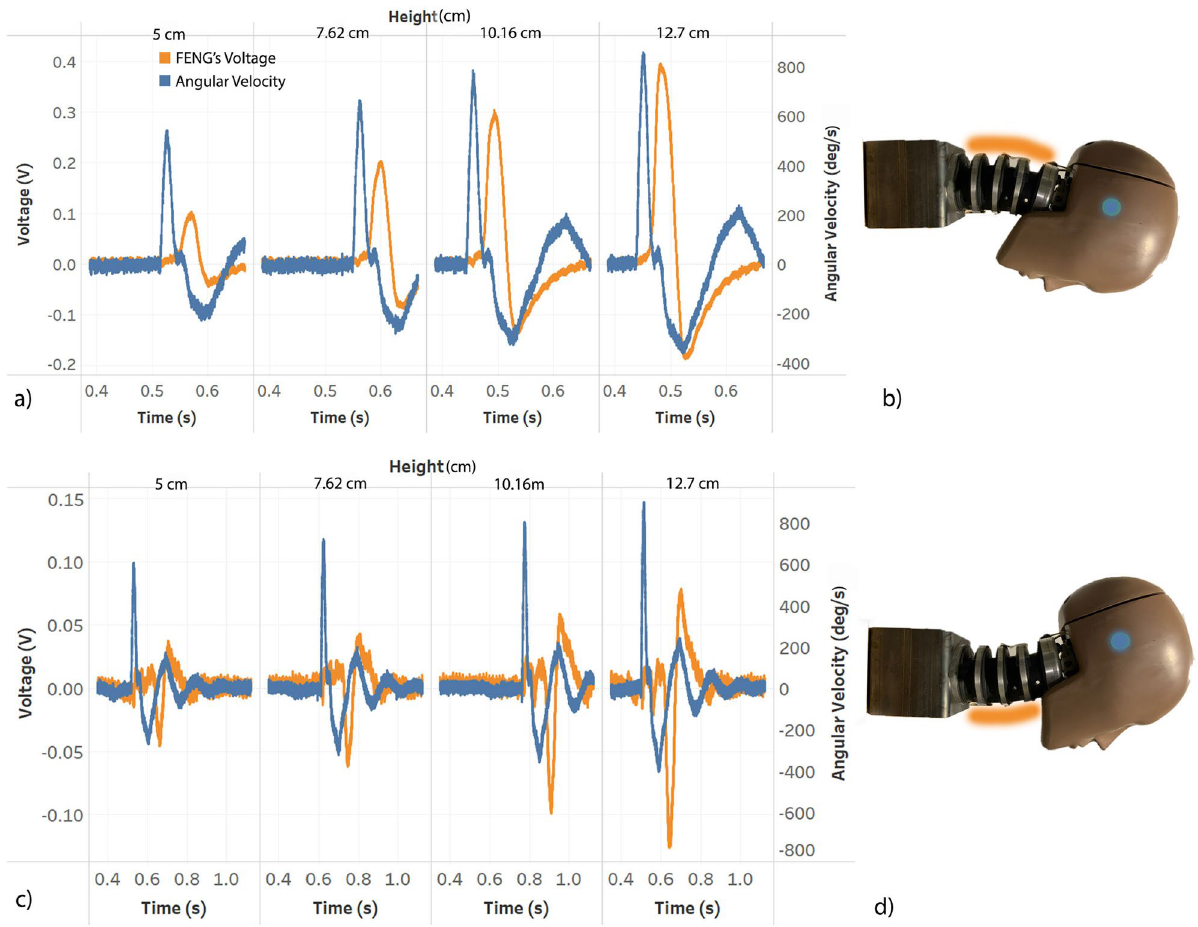
Figure 3. Measured responses to hyper-flexion and hyper-extension of the neck. ( a ) Hyperflexion: Voltage response of the patch located at the back of the neck (as shown in ( b ), where the orange shade represents the patch location) and angular velocity from the 6DX for drop tests from various heights simulating frontal collision of the center plate. ( c ) Hyperextension: Voltage response of the patch located at the front of the neck (as shown in d) and angular velocity from the 6DX for drop tests from various heights simulating frontal collision of the center plate. Blue dots on ( b ) and ( d ) are rough estimations of the 6DX